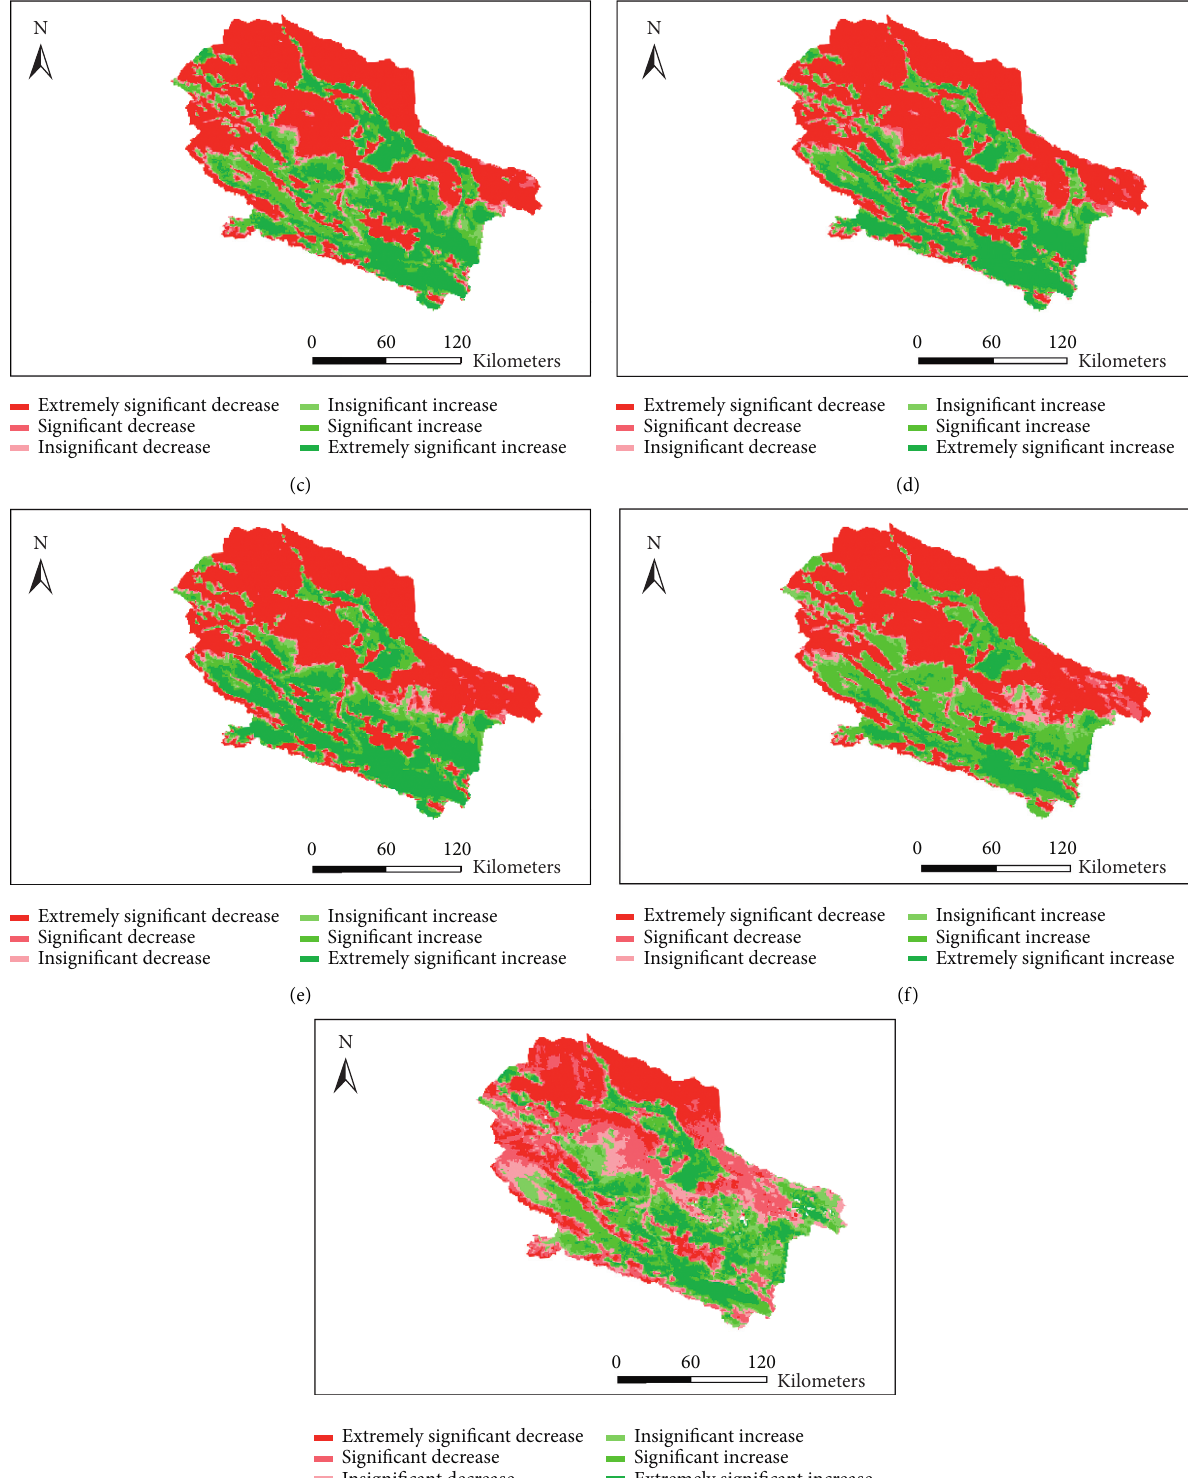
Figure 7: The spatial distribution of VCI trends for the growing season in the UHRB and